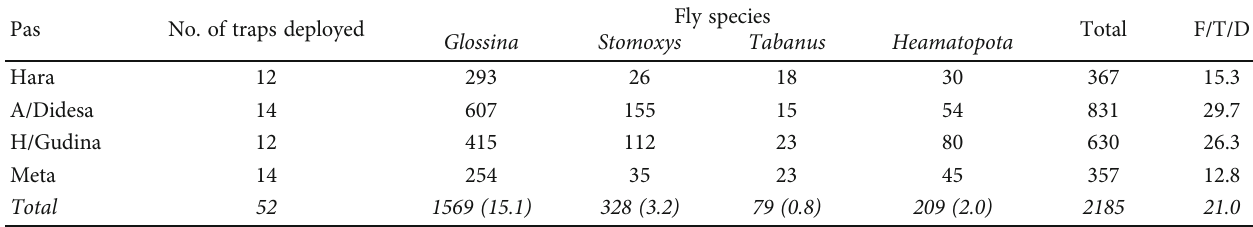
Table 5: The apparent density of fl y at di ff erent PAs in study area.